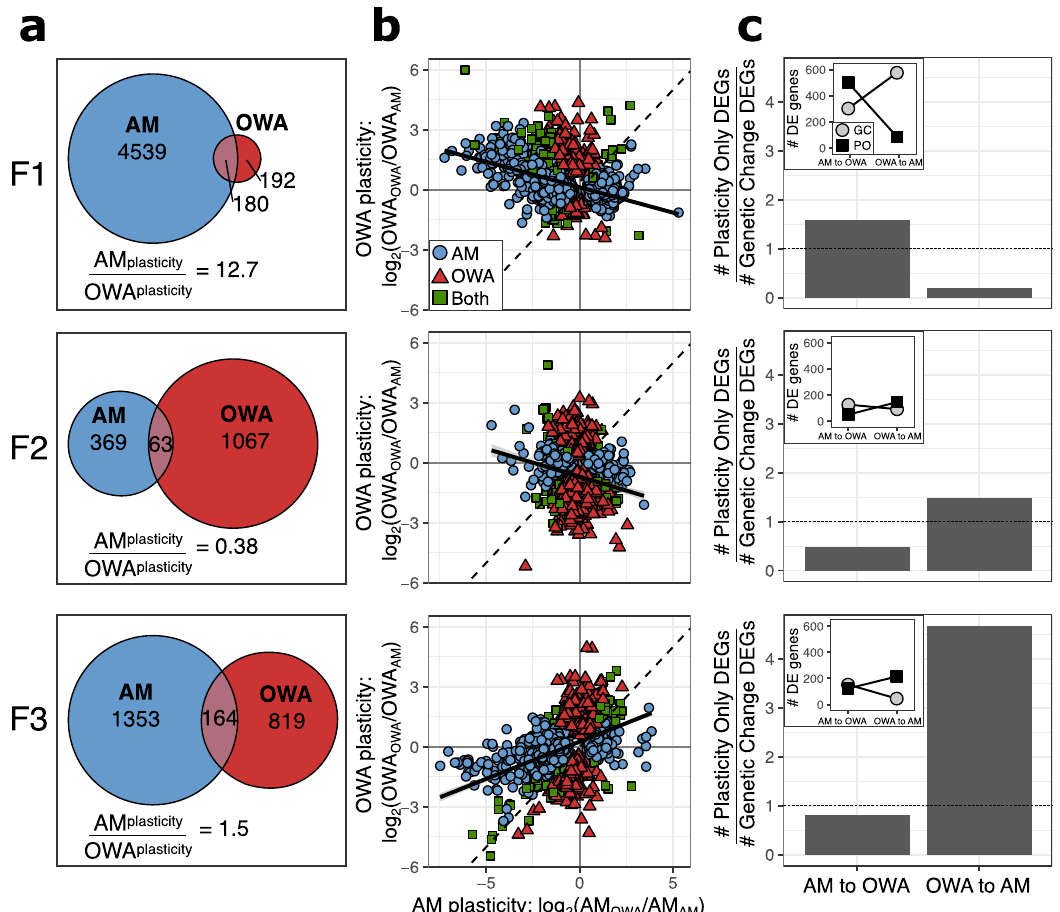
Fig. 3 Plasticity in gene expression in response to reciprocal transplant across three generations in transplant conditions. a Gene expression plasticity for AM and OWA transplanted lines as de fi ned by differentially expressed genes within a line following transplant (AM AM vs. AM OWA ; OWA OWA vs OWA AM ). b Comparison of plastic changes between AM and OWA lines. Color and shape indicate differentially expressed genes by one or both lines. If gene expression plasticity in response to the environment is equal between the two lines, the slope of the relationship would be 1 (dashed black line). The observed slope is shown as the solid black line. c Plastic vs. genetic changes in gene expression. Bar plots show the relative number of plastic vs. genetic changes in expression between AM AM and OWA OWA where the dashed line indicates equal numbers. AM to OWA indicates AM lines moving to OWA conditions (Forward adaptation), OWA to AM is the opposite (Reverse adaptation). Inset plots show the counts of the genes that went into the barplot where PO = plasticity only and GC = genetic change. All proportions of PO to GC signi fi cant at P < 0.001, two-sided G -test of independence. Source data are provided as a Source Data fi